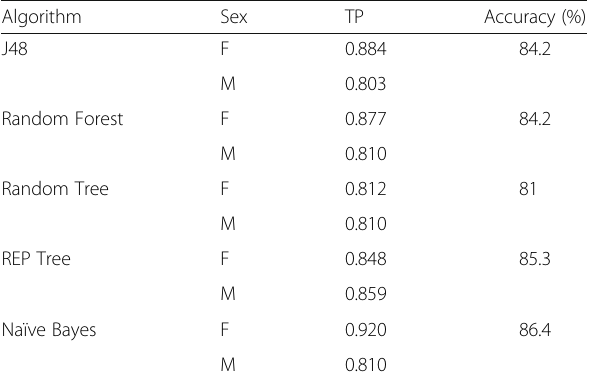
Table 6 Accuracy rates for sex determination through following algorithms by using toe 1 lengths and indexes Algorithm